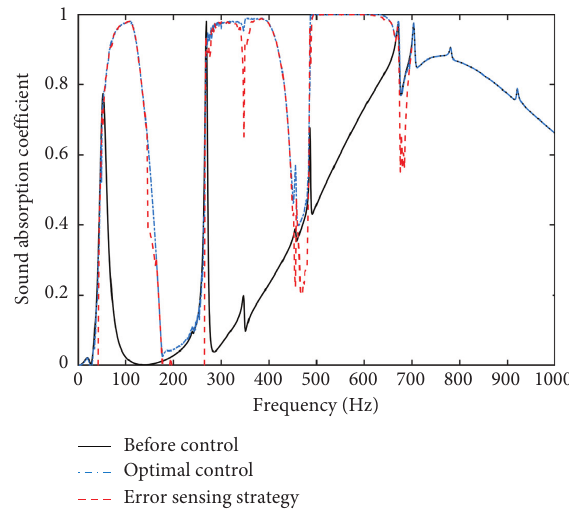
Figure 13: Active control results for the case of panel dimension being 0.3 m × 0.3m.